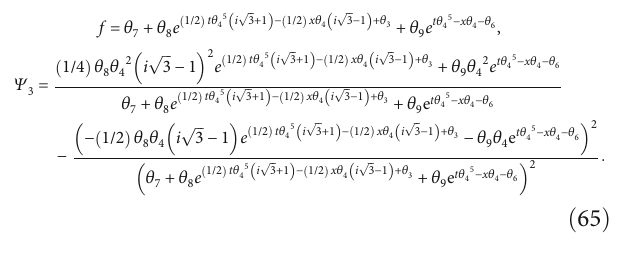
= 2, θ = 2, θ = 3, θ = 1 : 3, θ 4 3 6 7